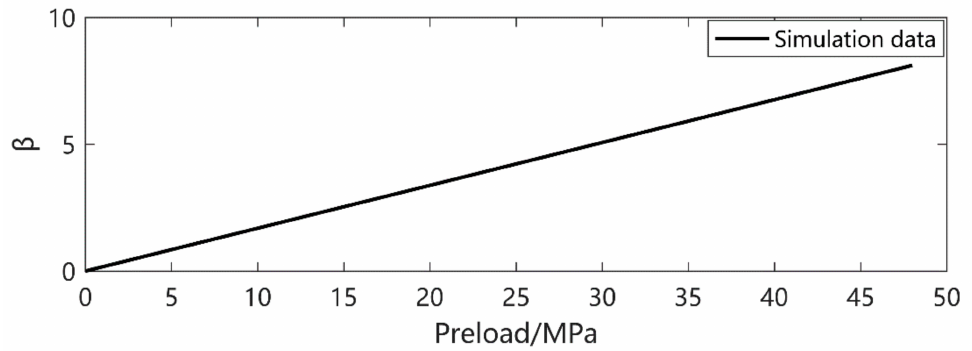
Figure 4. The adjustment parameter β value.